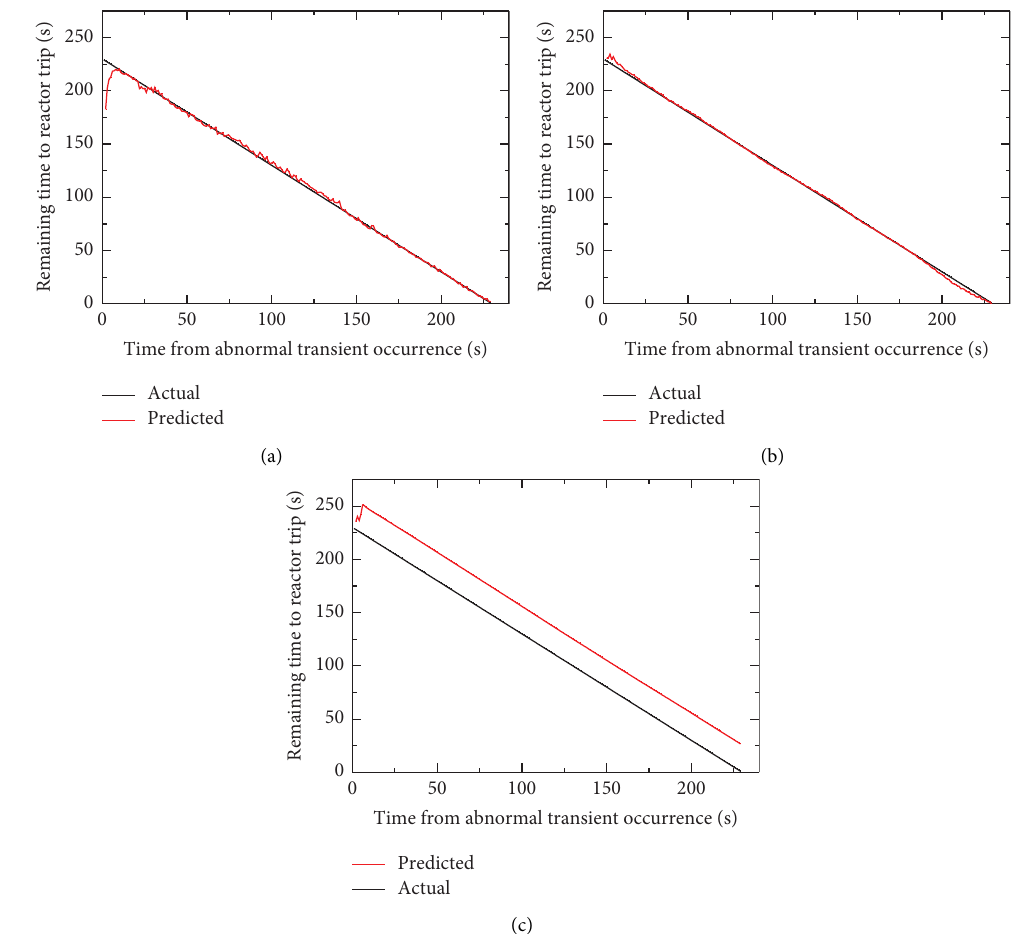
Figure 8: Prediction results for automatic scram generated by Elman neural network models: (a) training RMSE � 5.00; (b) training RMSE � 0.50; (c) training RMSE �